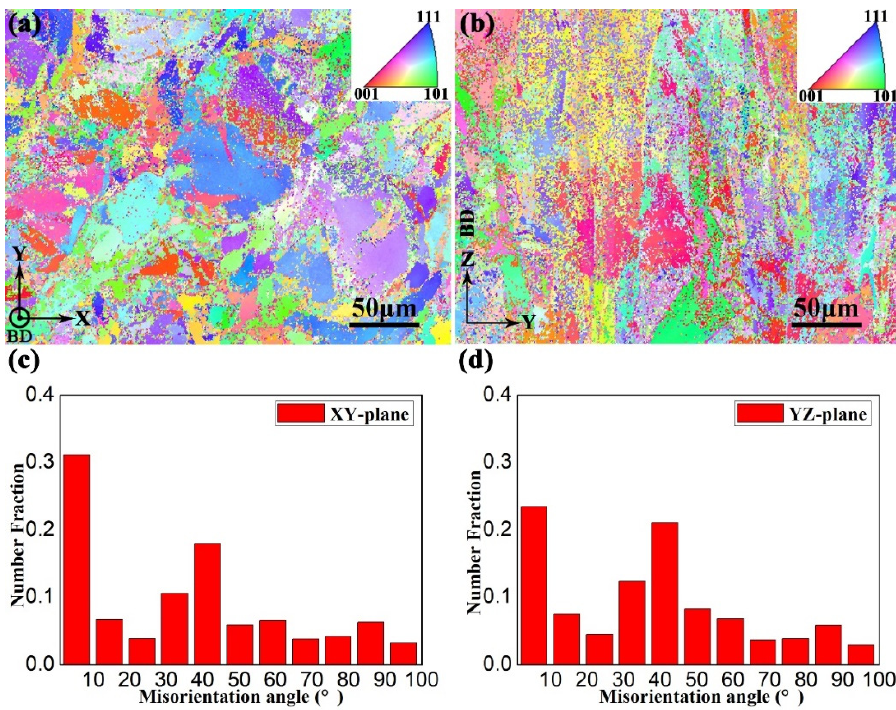
Figure 11. The EBSD inverse pole figure (IPF) maps of sample H-X at ( a ) XY- and ( b ) YZ-planes. Misorientation angle distribution at ( c ) XY- and ( d ) YZ-planes.